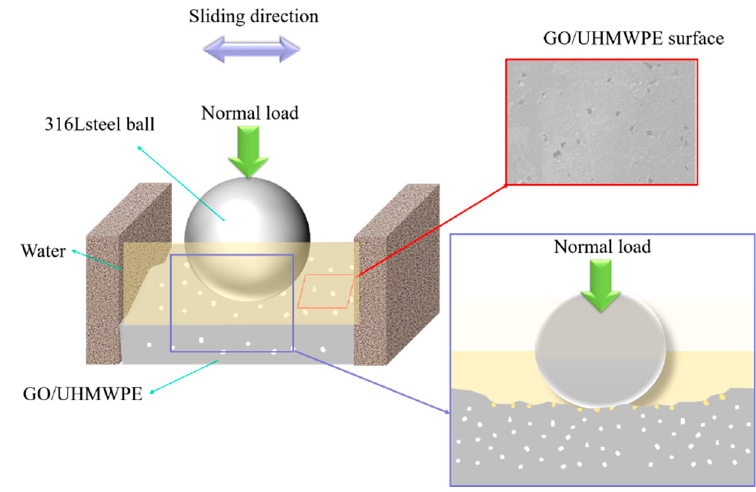
Figure 12. Schematic diagram of friction of porous GO/UHMWPE materials.